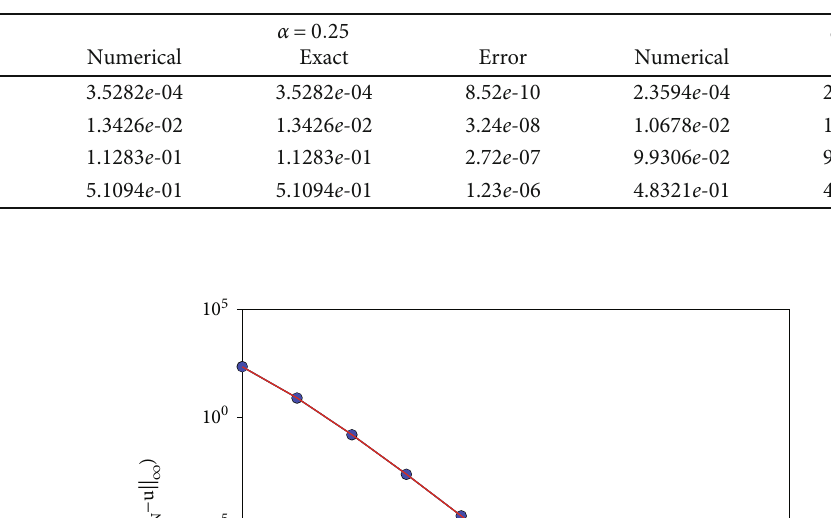
Table 2: Numerical and exact solutions of Equation (22) and absolute errors when M = 12 and N = 16 .